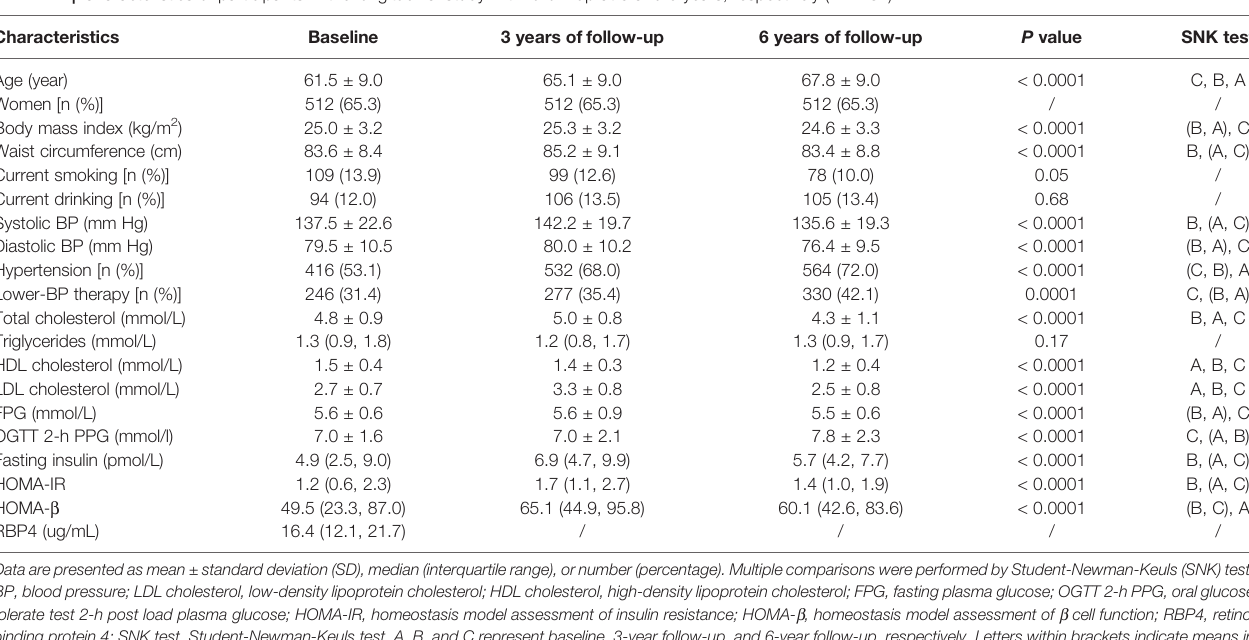
(model 1), baseline serum RBP4 levels were positively associated